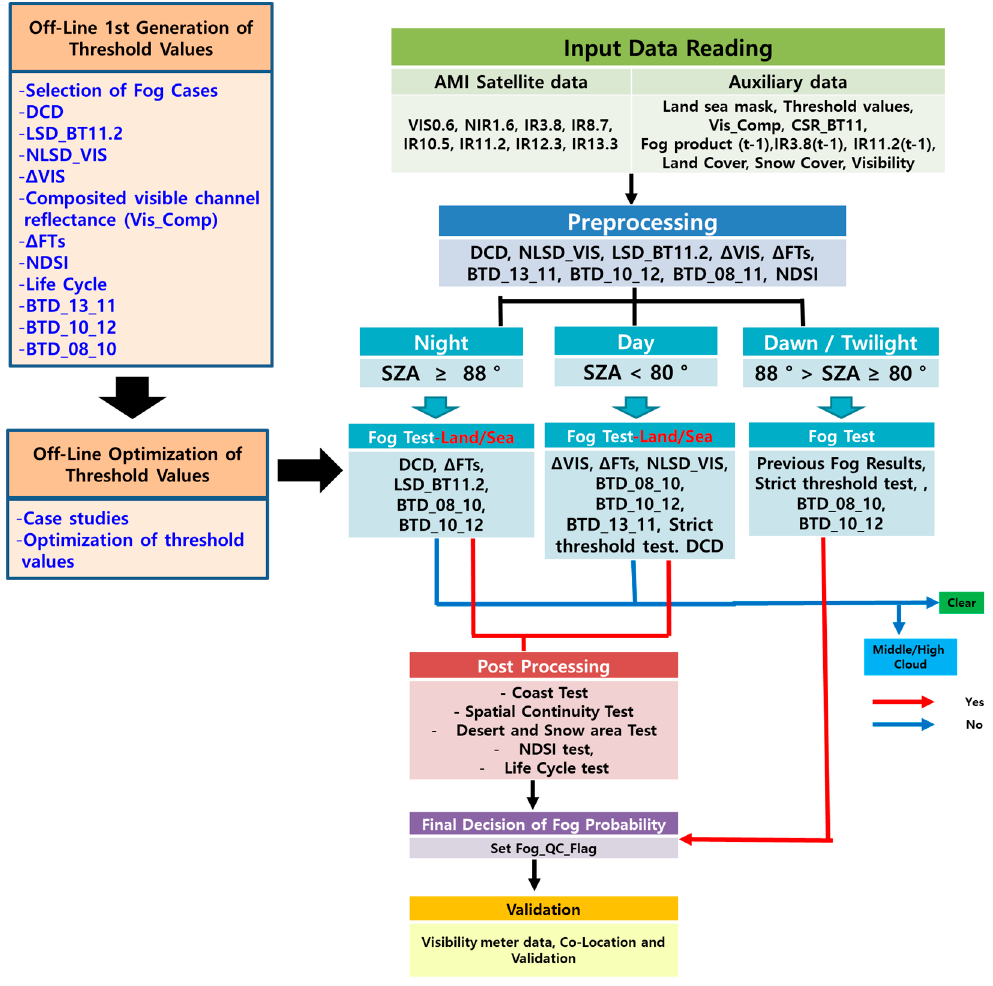
Figure 2. Flow chart of the fog detection algorithm prepared using the GK2A/AMI and auxiliary data.